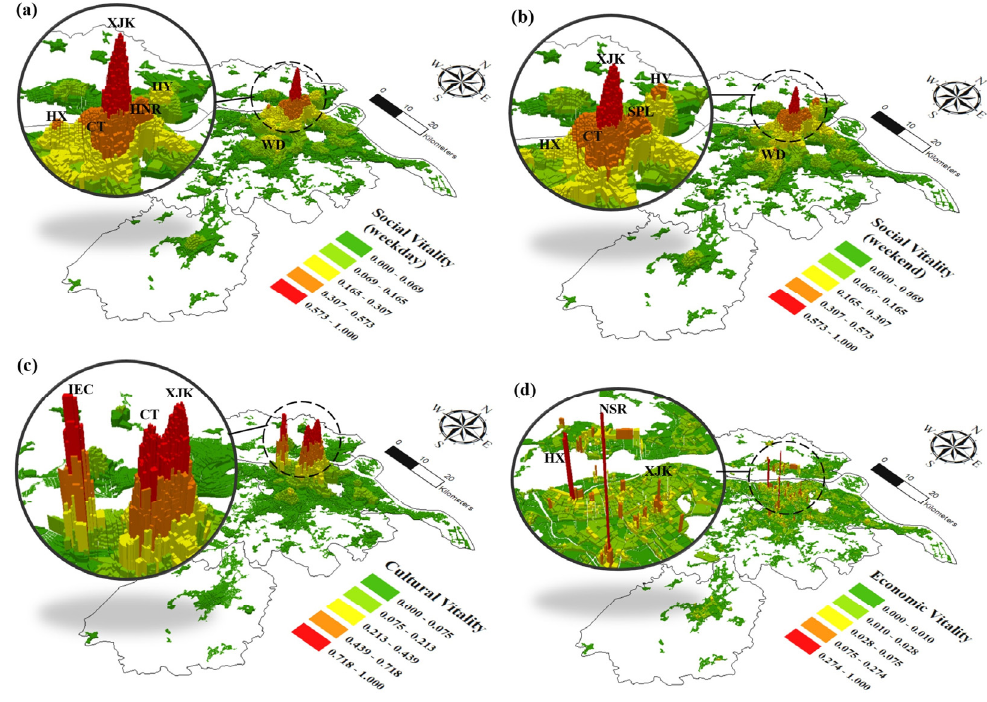
Figure 8. Distribution of vitality values: ( a ) social vitality on weekdays; ( b ) social vitality on weekends; ( c ) cultural vitality; and ( d ) economic vitality.